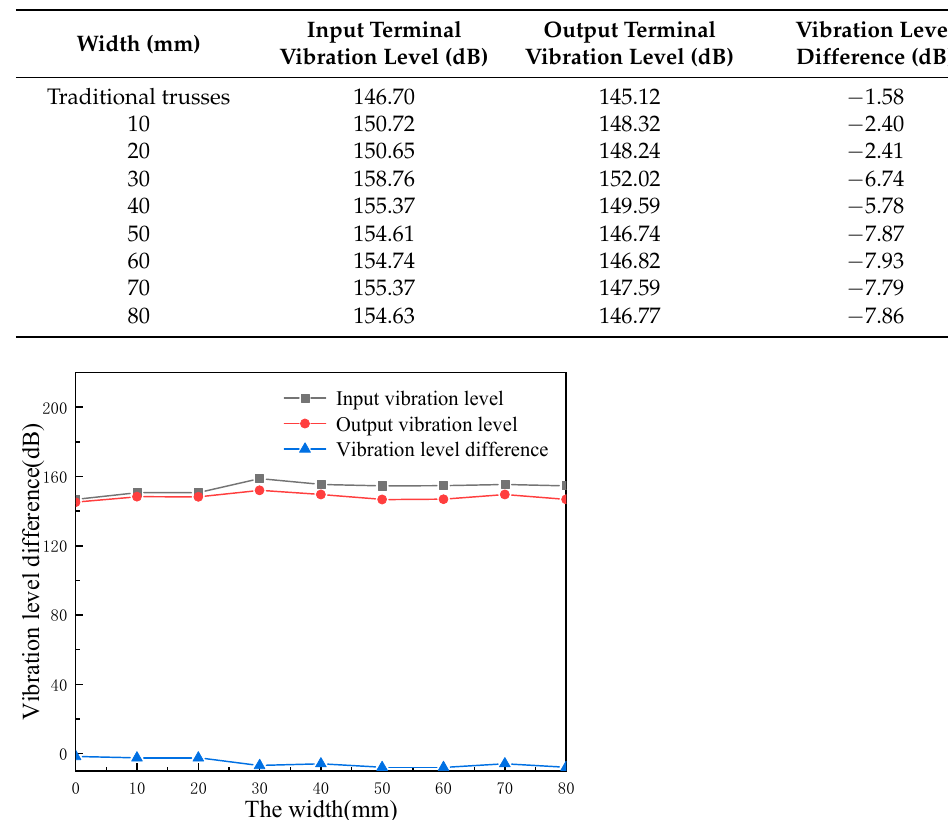
Figure 18. Offshore platform truss structure model. Table 5. The effect of local resonance width on vibration level.